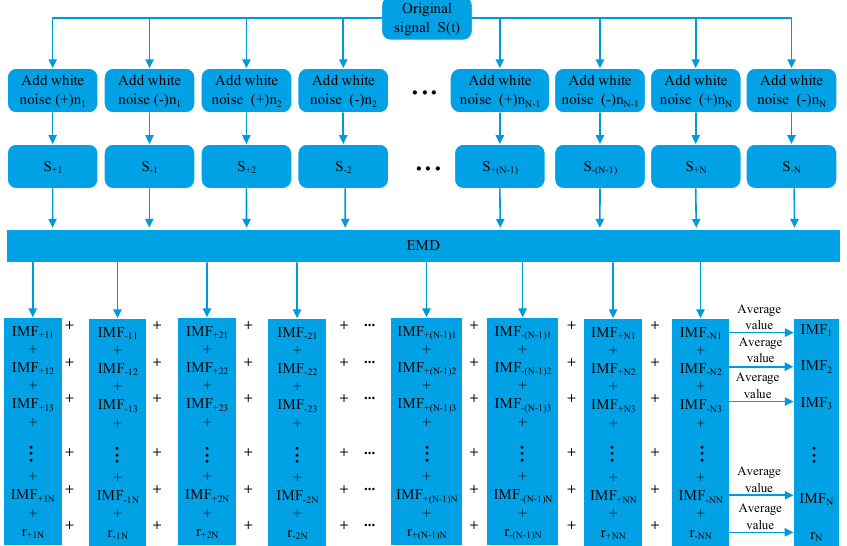
Figure 1. Complementary ensemble empirical mode decomposition (CEEMD) Figure 1. C omplementary ensemble empirical mode decomposition (CEEMD) flowchart.